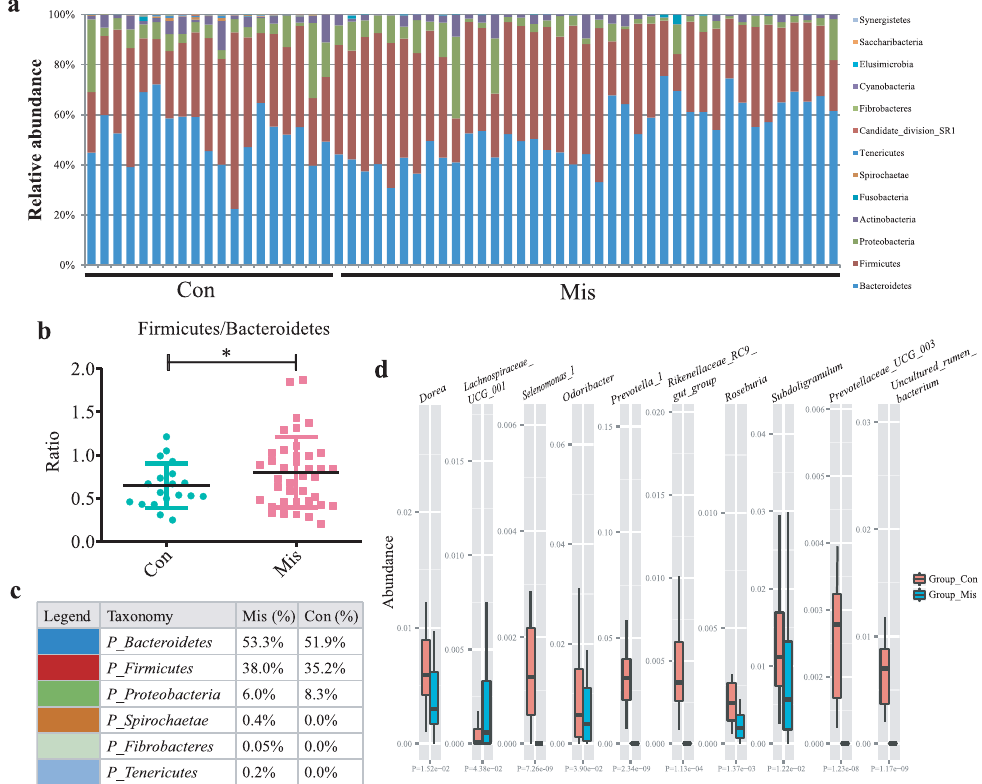
Fig. 2 Gut microbial dysbiosis in miscarriage patients. a Relative abundance of the main bacterial phylum in each group. b The ratio of Firmicutes / Bacteroidetes in each group. Data are shown as mean ± SD. * p < 0.05. c Component proportion of bacterial phylum in each group. n = 41 for the miscarriage (Mis) group and n = 19 for the control (Con) group. d The top 10 signi fi cantly different genera in the relative abundances between the control and miscarriage groups; Kruskal – Wallis, all p <